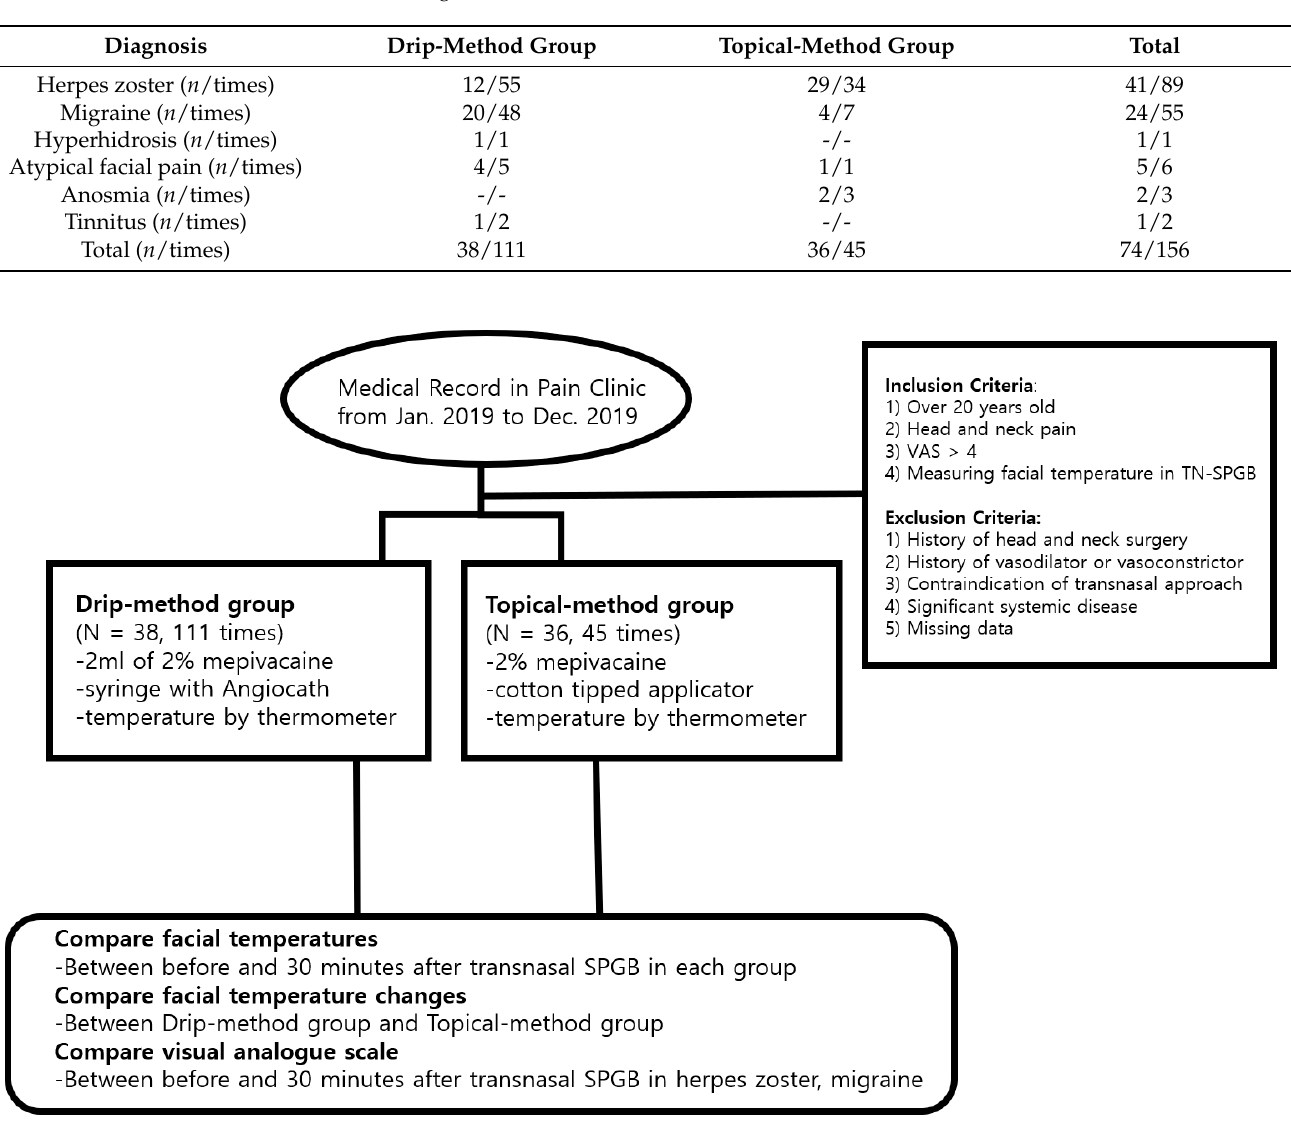
Figure 4. Flowchart of research. Visual analogue scale (VAS); sphenopalatine ganglion block (SPGB).